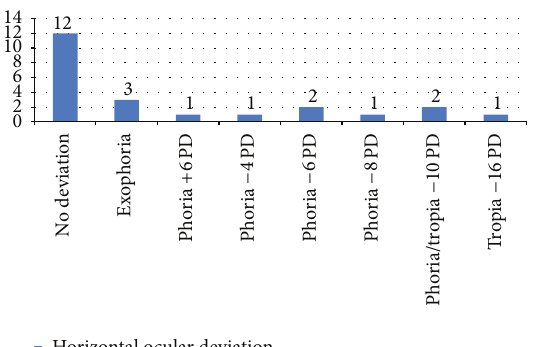
Figure 4: Cover test: evaluation of horizontal deviation for near with the lens.